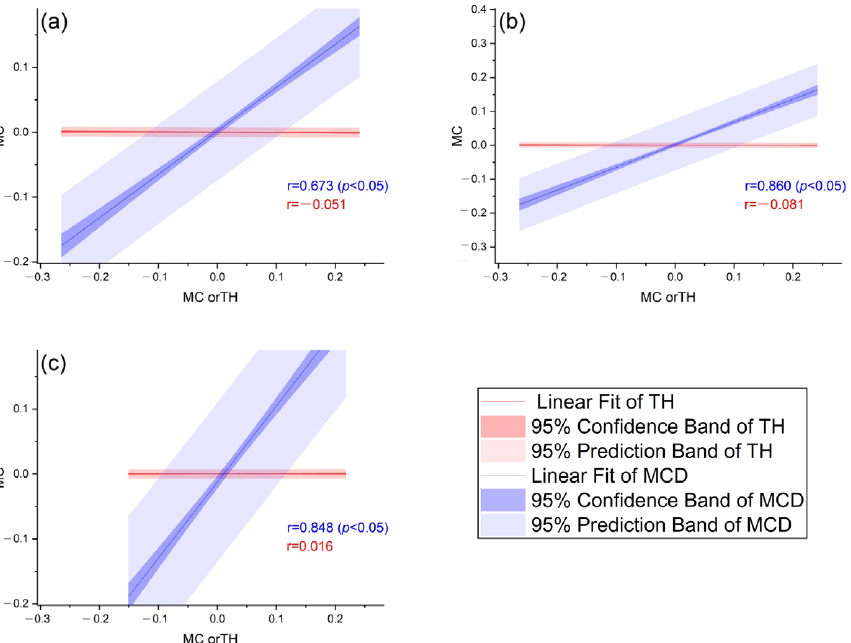
Figure 7. Relative contribution of soil moisture to each component of moisture convergence in the wet ( b ), dry seasons ( c ), and the whole year ( a ). Red is the contribution of the thermodynamic component (TH) to moisture convergence, and blue is the contribution of the mean circulation dynamic component (MCD) to moisture convergence.